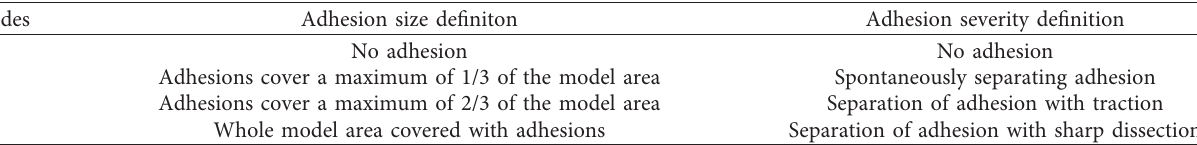
Table 1: Definitions of macroscopic adhesion scoring.